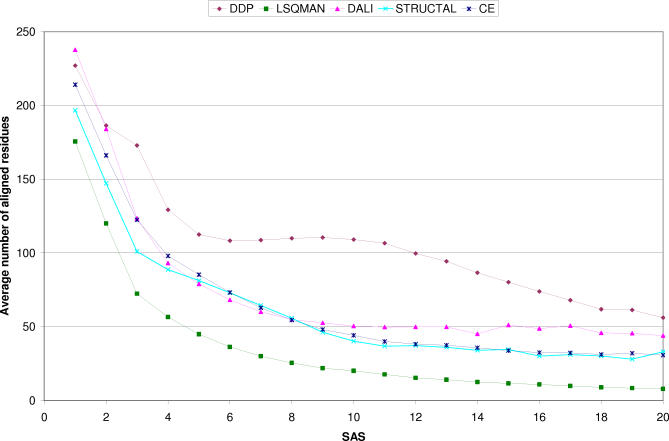
Average Number of Aligned Residues per SAS